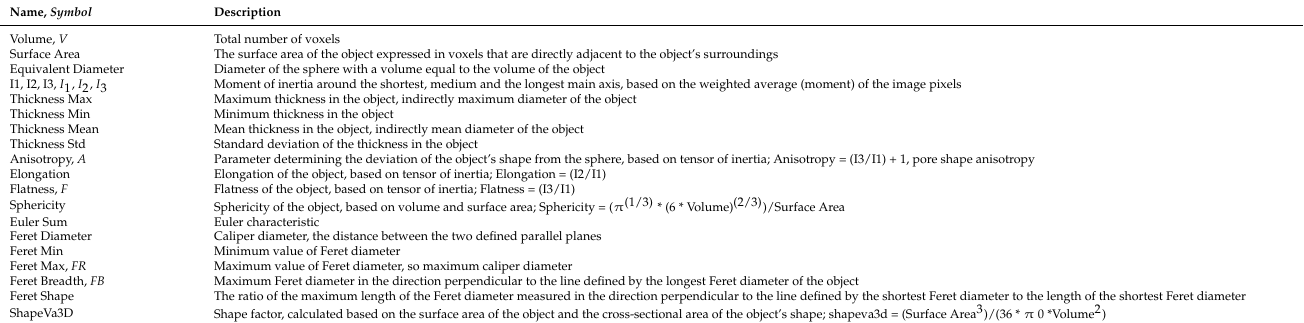
Table A2. List of